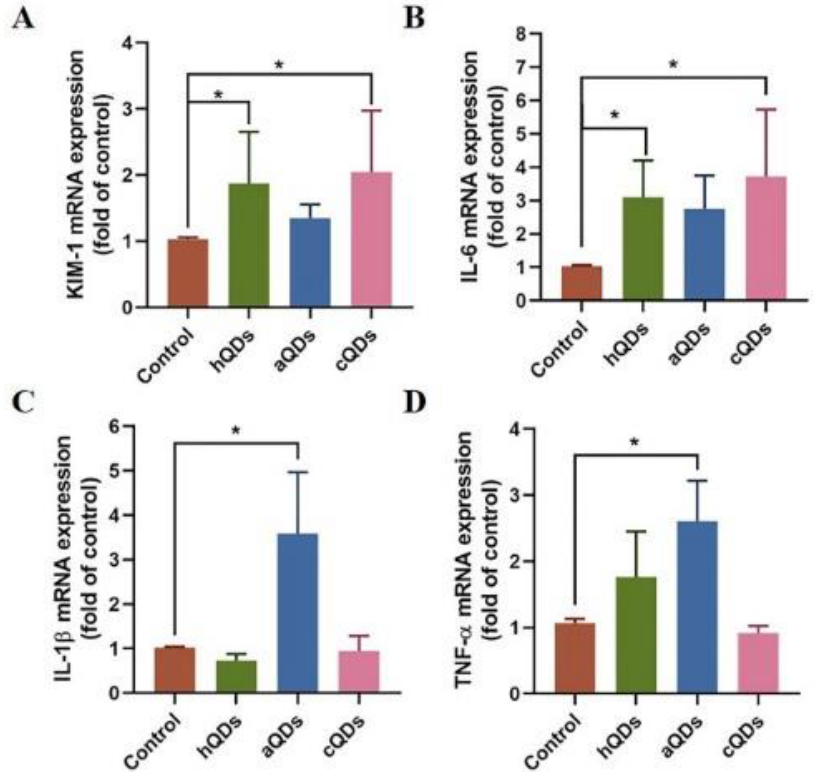
Figure 6. The mRNA levels of KIM-1 and inflammation-related genes in mouse kidney on Day 1 after administration of 25 mg/kg BW QDs. ( A ) KIM-1 mRNA levels. ( B ) IL-6 mRNA levels. ( C ) IL- 1β mRNA levels. ( D ) TNF- α mRNA levels. (* Significantly different compared to control group, p < 0.05).